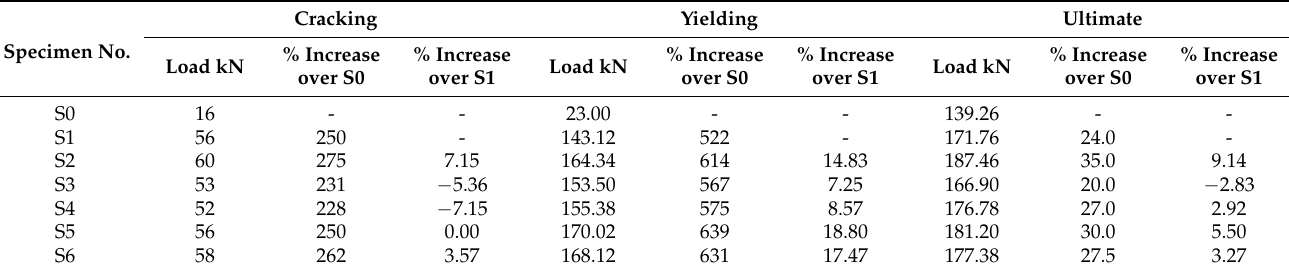
Table 4. Load–carrying capacity results of all beams.